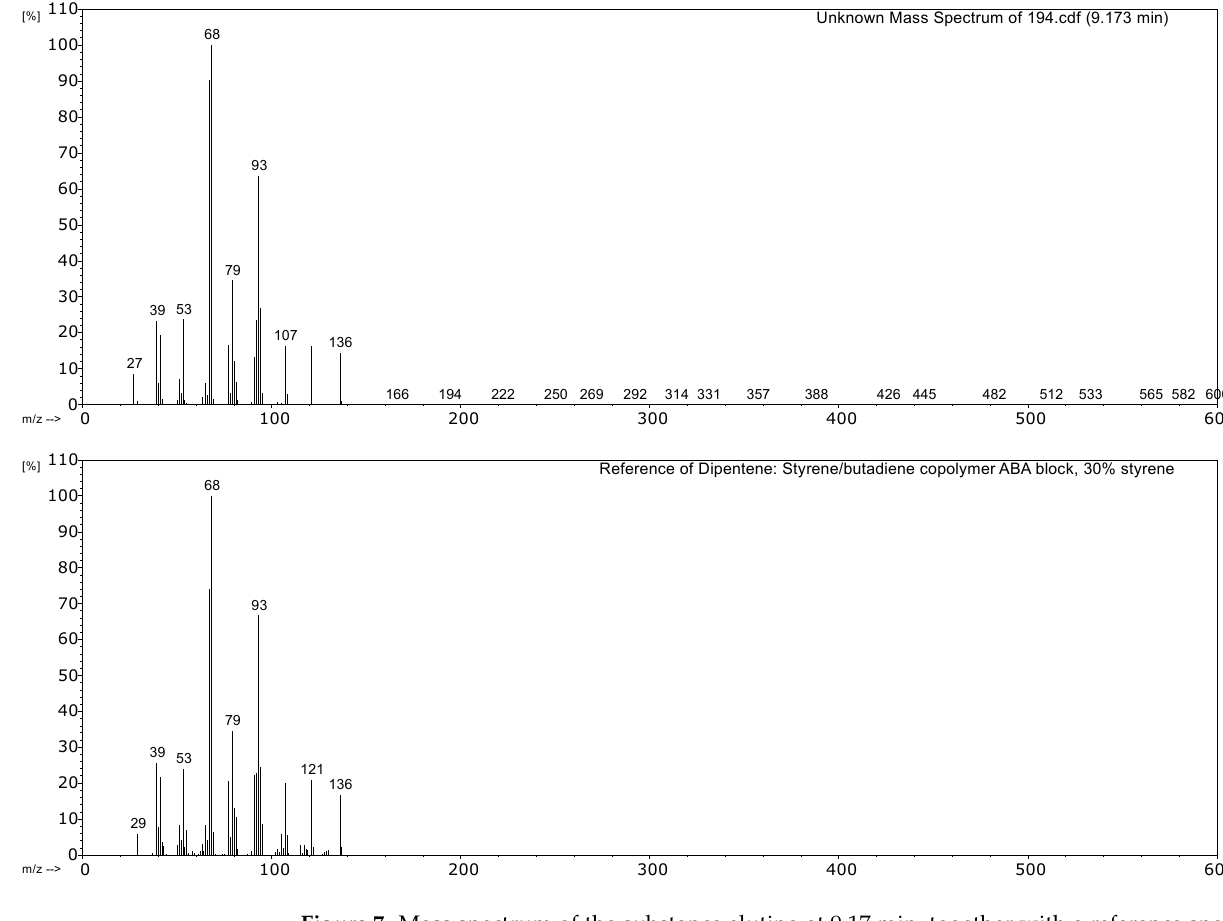
Figure 7. Mass spectrum of the substance eluting at 9.17 min, together with a reference spectrum from F ‐ Search.